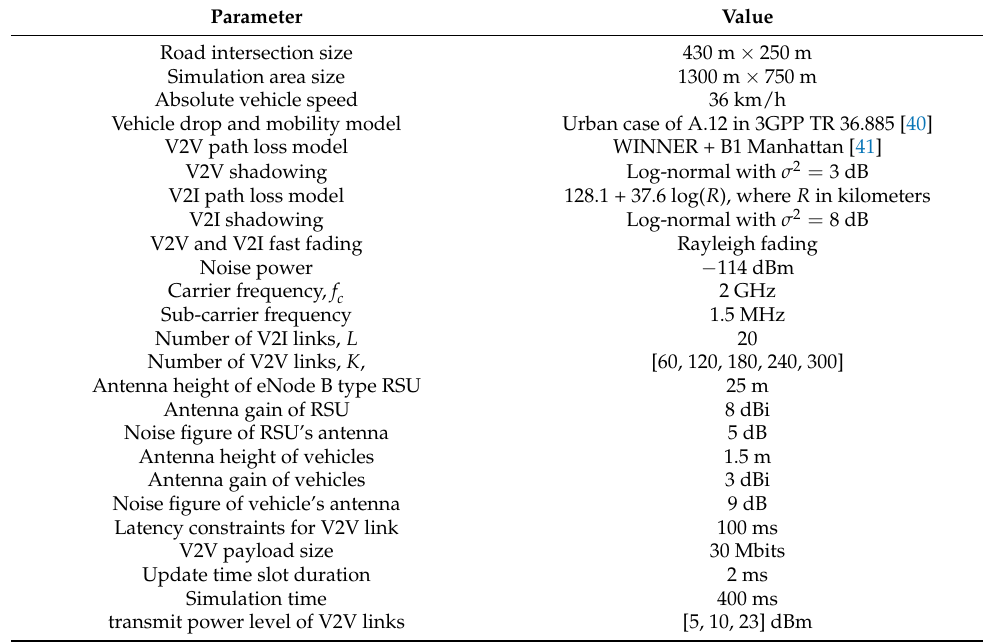
Figure 4. Vehicle movements. Table 1. Simulation